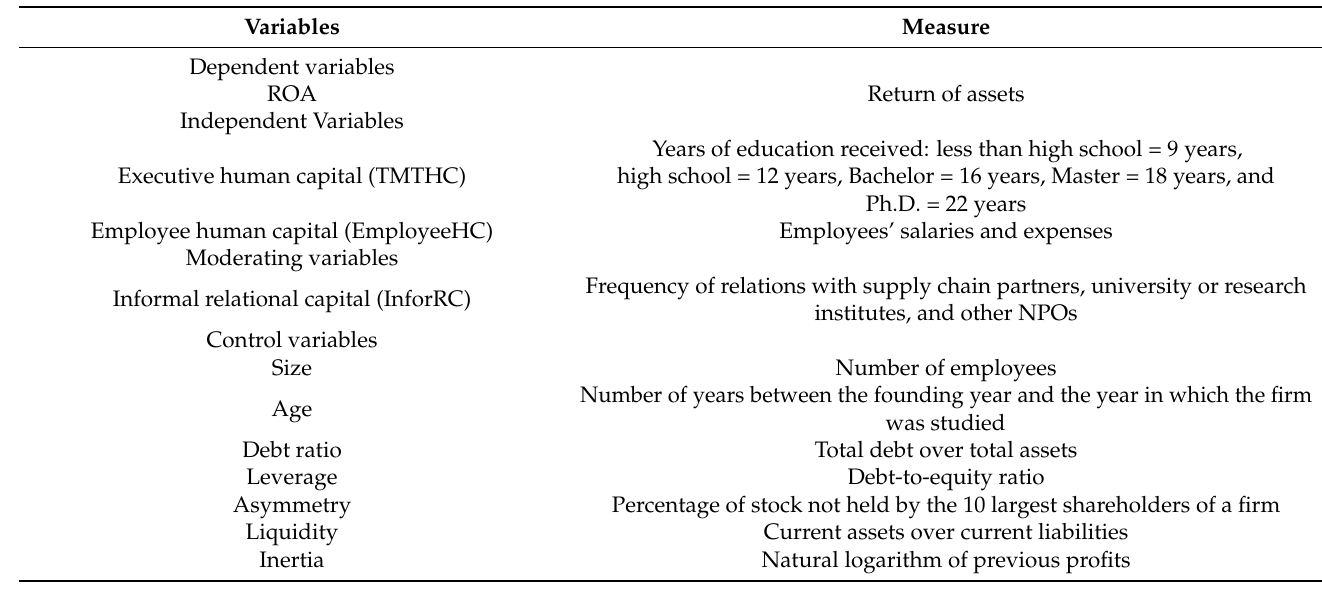
Table 1. Coding and measurement of the